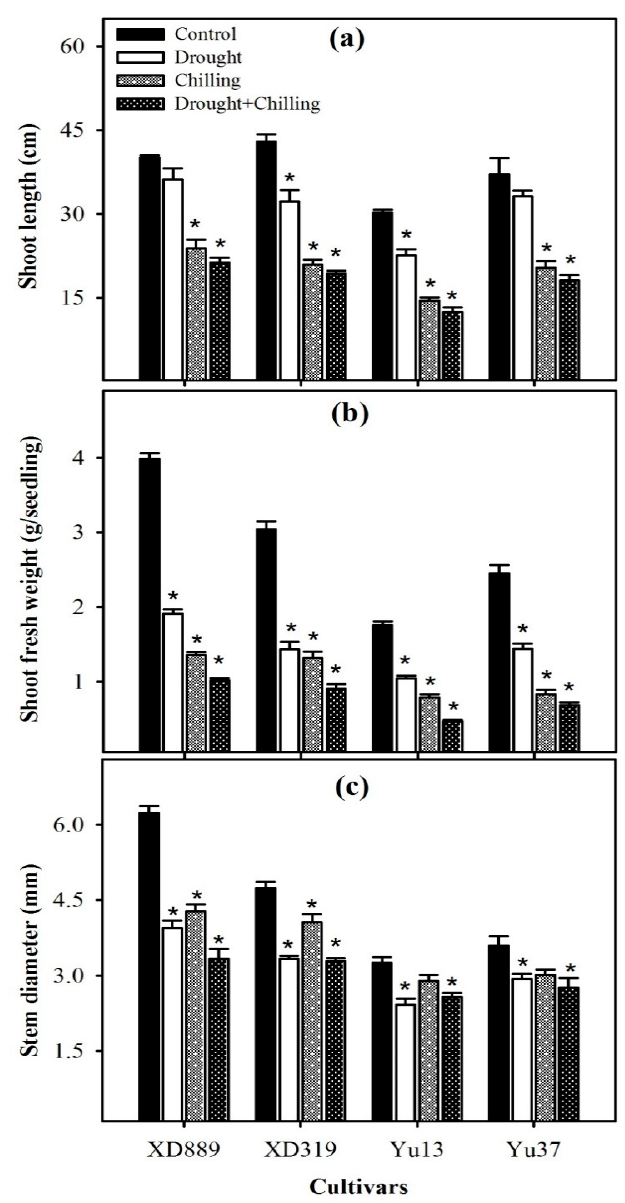
Figure 1. Shoot length ( a ), shoot fresh weight ( b ), and stem diameter ( c ) of four maize cultivars as influenced by drought, chilling, and drought + chilling stress. Vertical bars above mean indicate standard error of three replicates. Mean value for each treatment with * indicate significant differences compared with control according to least significant difference (LSD) test ( P ≤ 0.05).